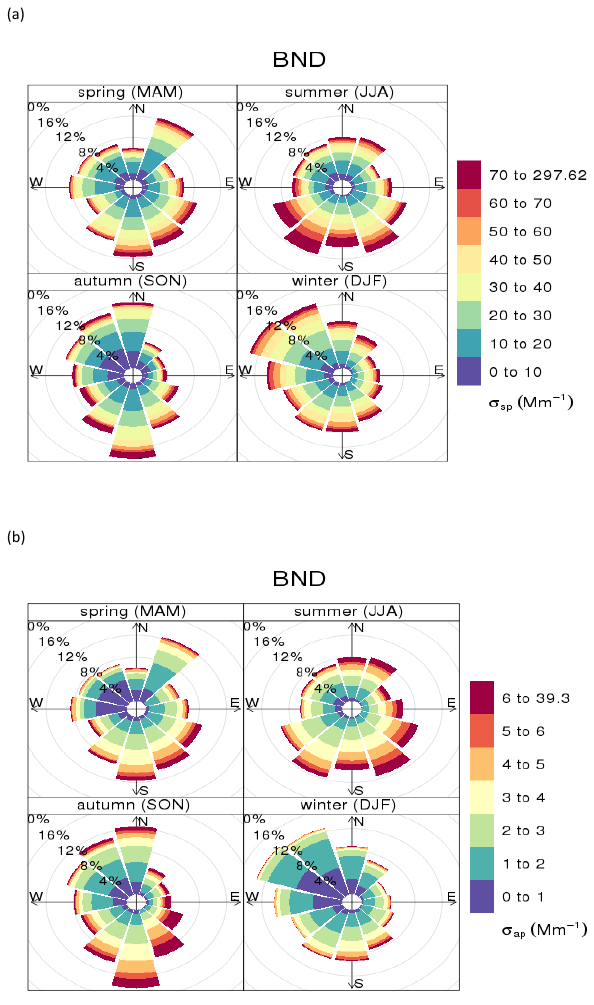
Figure 6. Pollution rose diagrams of PM 1 σ sp and σ ap for individual seasons at BND over the 2010–2013 period. The percentages at a given radius represent the percentage of hourly profiles for a given wind